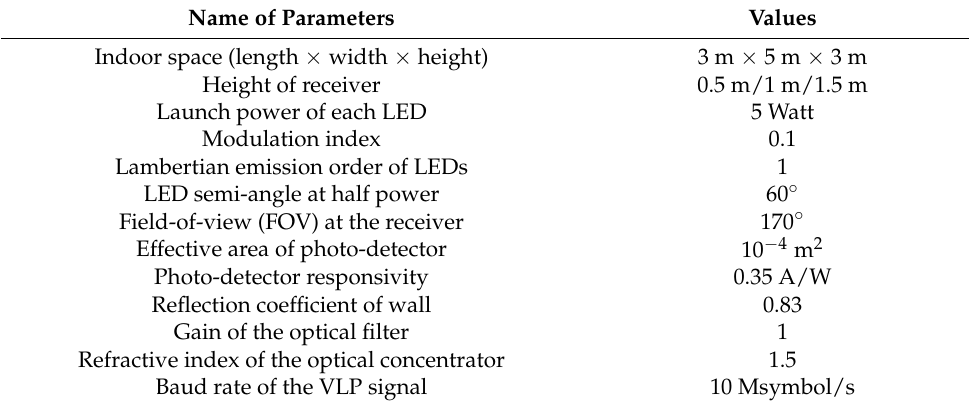
Table 2. Key parameters of the VLPO